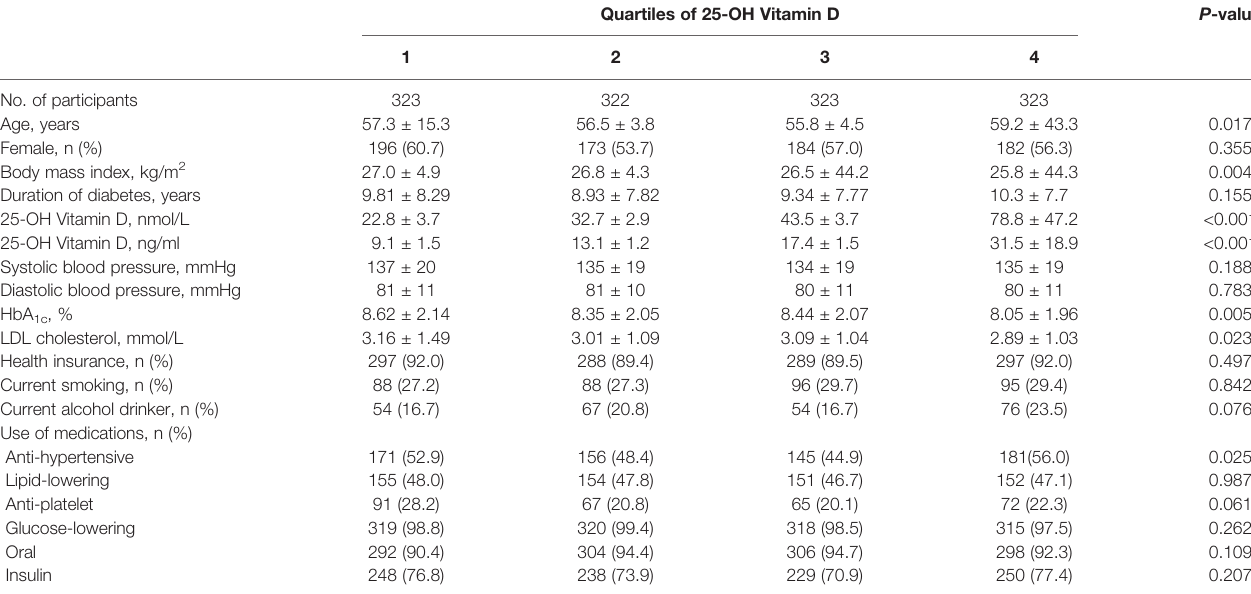
TABLE 1 | Baseline characteristics of the study participants according to quartiles of 25-OH vitamin D.